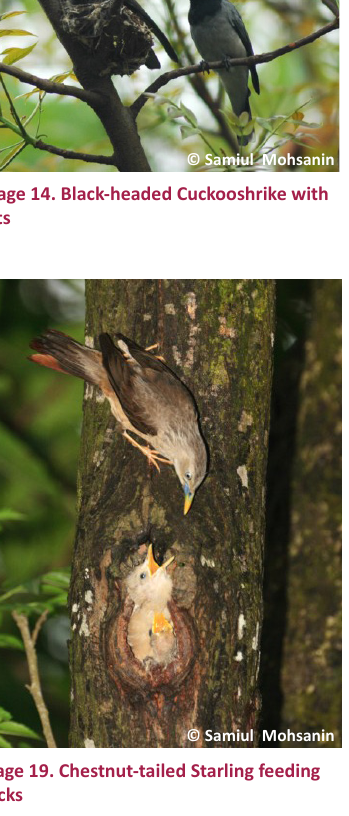
Image 20. Coppersmith Barbet